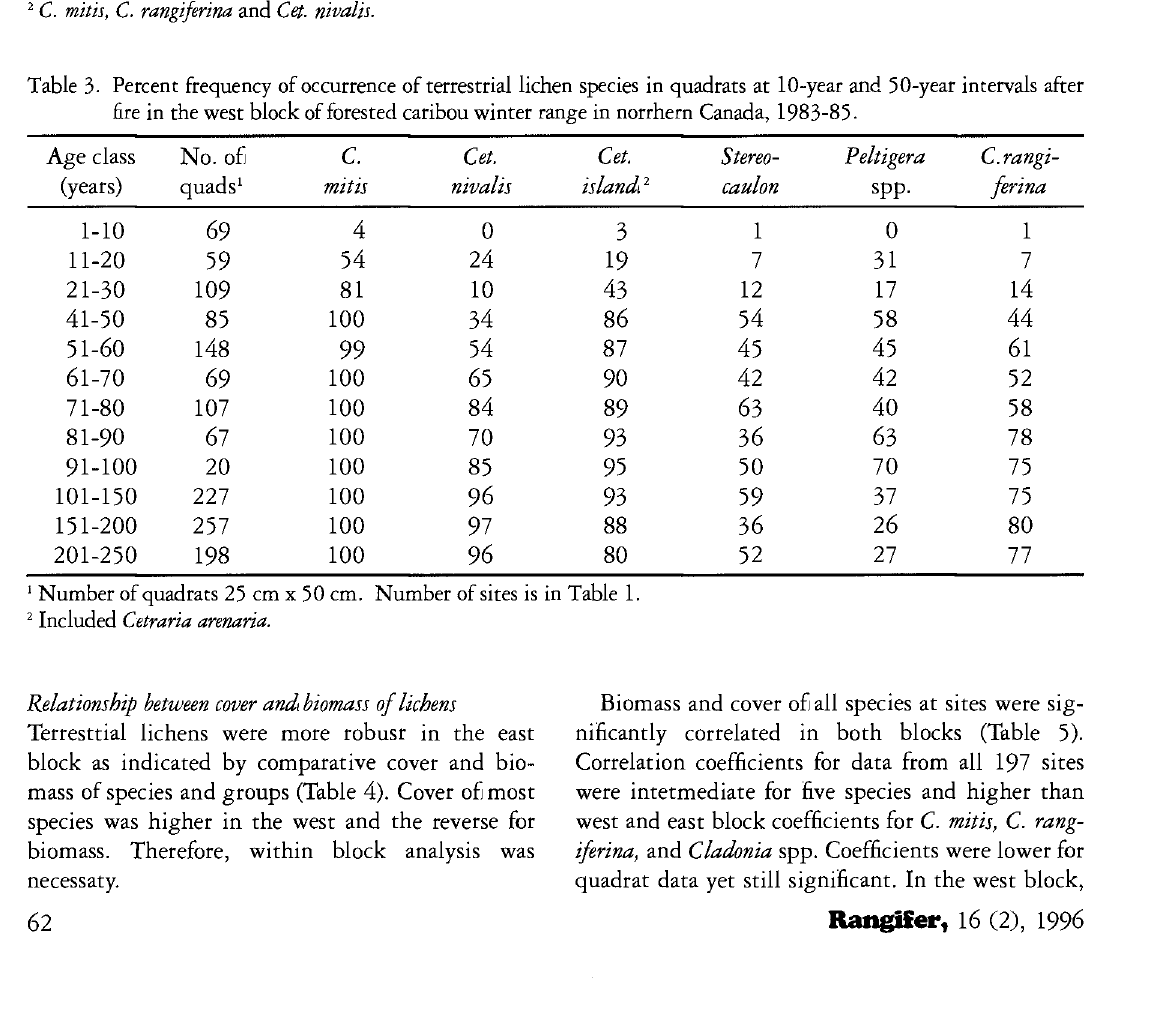
81-100 101-150 23 151-200 201-250